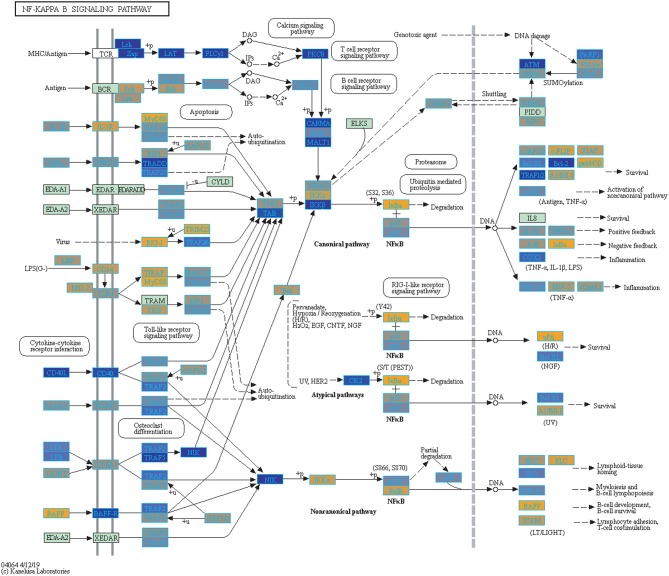
Highlighted NF-Kappa B Signaling KEGG Pathway (hsa04040) with Enriched Genes from the LRT Analysis (Bonferroni-adjusted p < 0.05) for Influenza Infected Subjects (47–49). Yellow-colored genes are up-regulated and blue-colored genes are down-regulated in Influenza Infected Subjects.